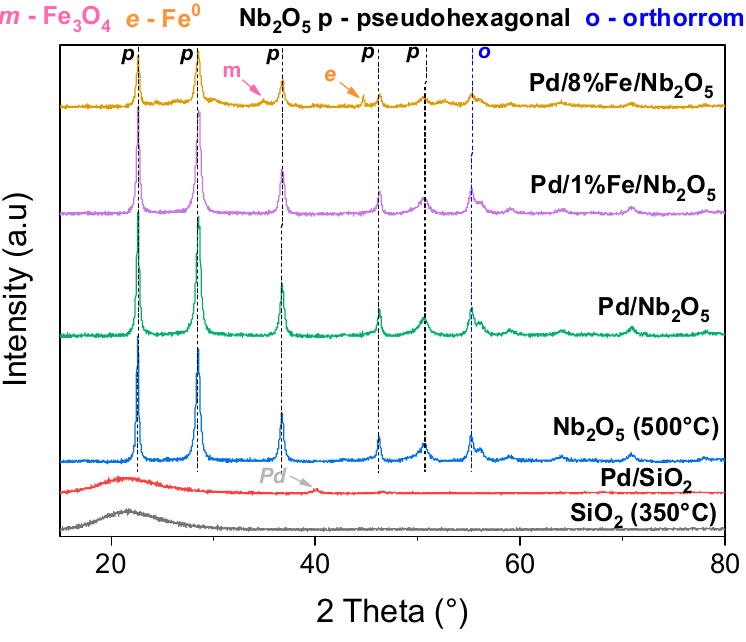
Figure 13. XRD-diffractogram of SiO 2 and Nb 2 O 5 supports after calcination and of the catalysts Pd/SiO 2 , Pd/Nb 2 O 5 , Pd/1%Fe/Nb 2 O 5 and Pd/8%Fe/Nb 2 O 5 after reduction under H 2 .